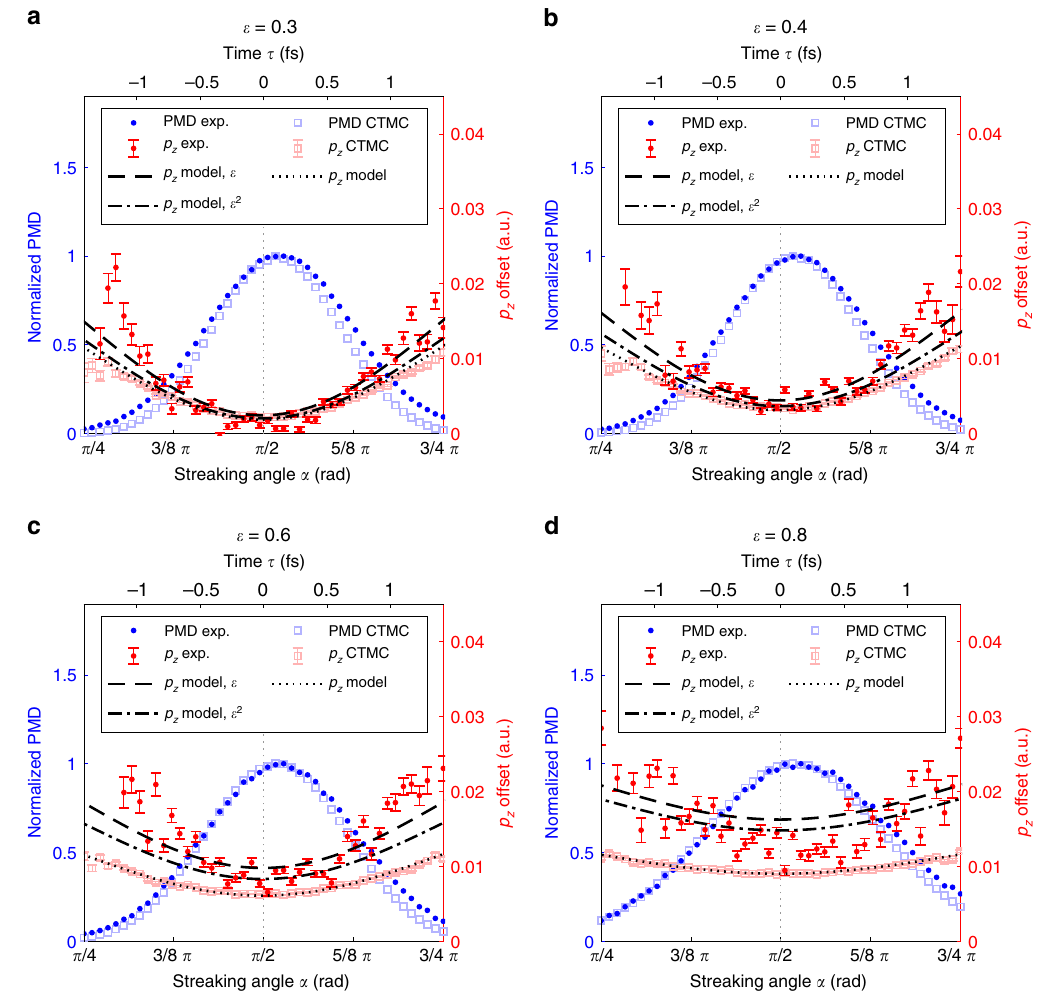
Fig. 3 Sub-cycle dependence of linear momentum transfer. Angular distributions for various ellipticities of the p z -shift (red) together with the normalized electron yield (blue) from the experimental data (PMD exp., p z exp.). In addition, we show the corresponding results from our classical trajectory Monte- Carlo (CTMC) simulations (PMD CTMC, p z CTMC) and the theoretical prediction for a peak intensity of I 0 ¼ 4 (cid:3) 10 13 W cm (cid:1) 2 based on a classical model ( p z model) and an extended version with an additional initial momentum component along p z ( p z model, ϵ and p z model, ϵ 2 ) (for details see main text, Supplementary Notes 2 – 5 and Supplementary discussions). The error bars are of purely statistical nature and are based on the 1 σ -uncertainty from the gaussian fi t used to extract the p z -shift for each angular